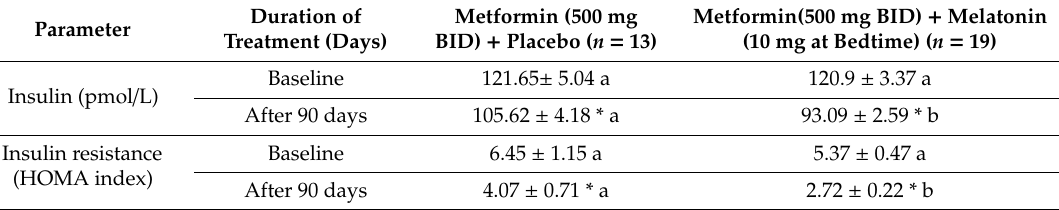
Table 2. E ff ect of treatment with metformin–melatonin versus metformin–placebo on the serum insulin level and the insulin resistance based on the homeostatic model assessment (HOMA) index in MEBS patients.